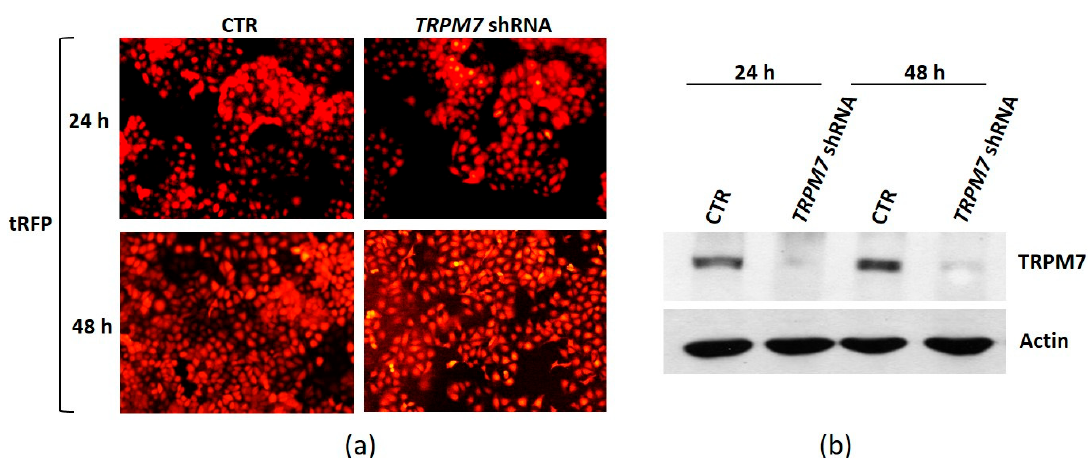
Figure 2. Generation of TRPM7-silencing HUVEC. The lentiviral vector pTRIPZ containing TRPM7 shRNA or non-silencing shRNA was transfected in HUVEC. The transfected cells were cultured in the presence of doxycycline for 24 and 48 h to induce TRPM7 shRNA (TRPM7 shRNA) or non-silencing shRNA (CTR) expression. ( a ) tRFP fluorescence was visualized in TRPM7 shRNA and non-silencing shRNA cells (CTR). ( b ) The levels of TRPM7 were evaluated by Western blot. Actin was used as control of loading. A representative blot is shown.